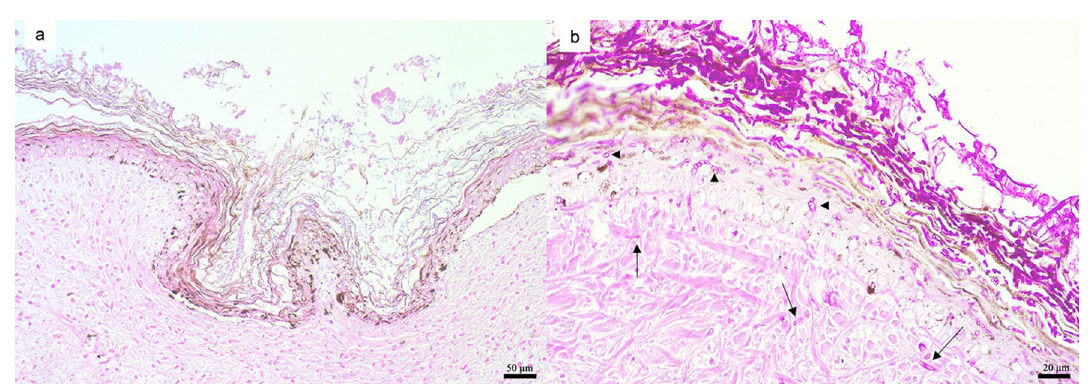
Figure 2. Nest 1 microscopical findings. Histological appearance of a section of an embryo’s skin ( a ) affected by multifocal degeneration of epidermal cells and orthokeratotic hyperkeratosis. ( b ) PAS stain underlined the presence of myriads of hyaline branched septate hyphae, 2 to 7 μm in diameter with thin, predominantly parallel wall attached to the skin, embedded within the epidermal layers (arrowhead) and in the superficial dermis (arrow). ( a ): hematoxylin and eosin staining, scale bar = 50 µm; ( b ): PAS staining, scale bar = 20